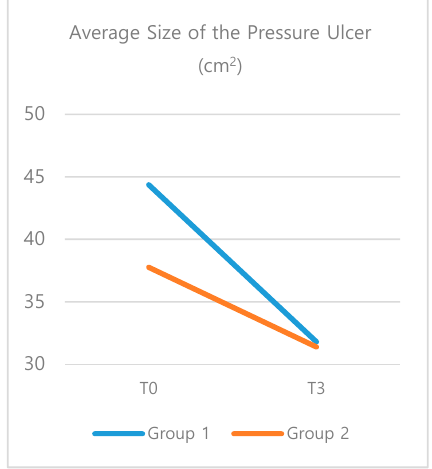
Figure 1. The average size of the pressure ulcer; Results of a two-way ANOVA indicated a significant reduction of the size of the wound in the experimental group (Group 1).